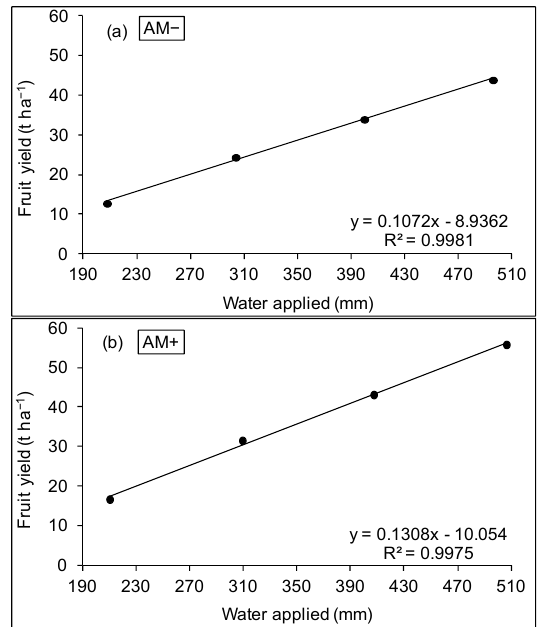
Figure 2. Relationship of total fruit yield versus the amounts of applied water (pooled AM − ( a ) and AM+ ( b ) of the two years), through regression analysis.